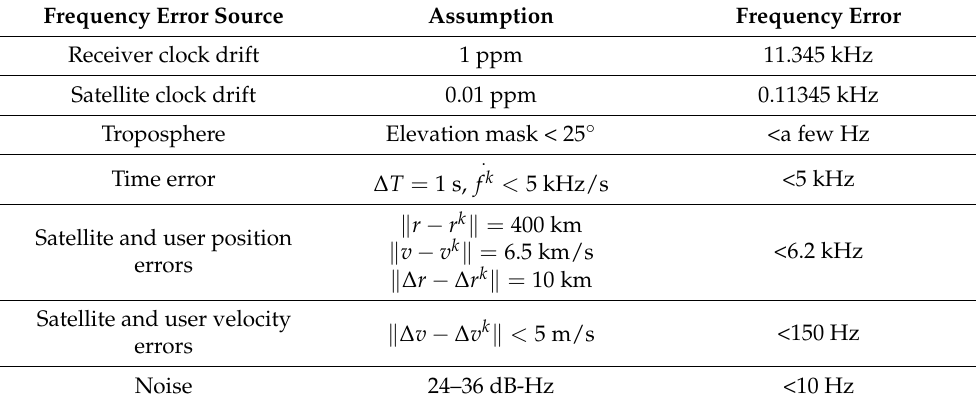
Table 2. An example of the frequency error